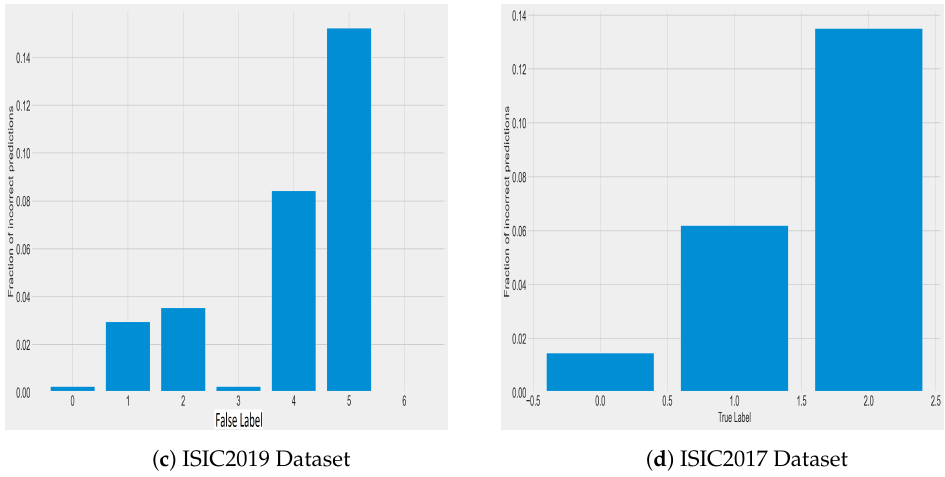
Figure 9. The incorrect values for each class using the HAM10000, ISIC2018 and ISIC2019, ISIC2017